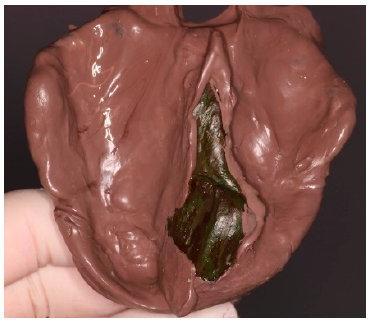
Figure 4. Custom tray with border molding.